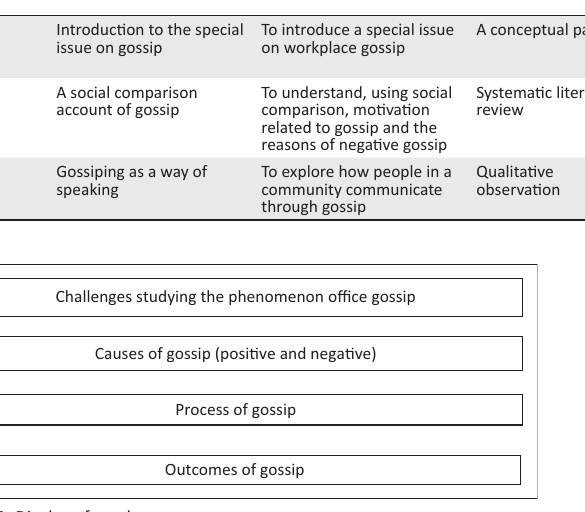
FIGURE 1: Display of